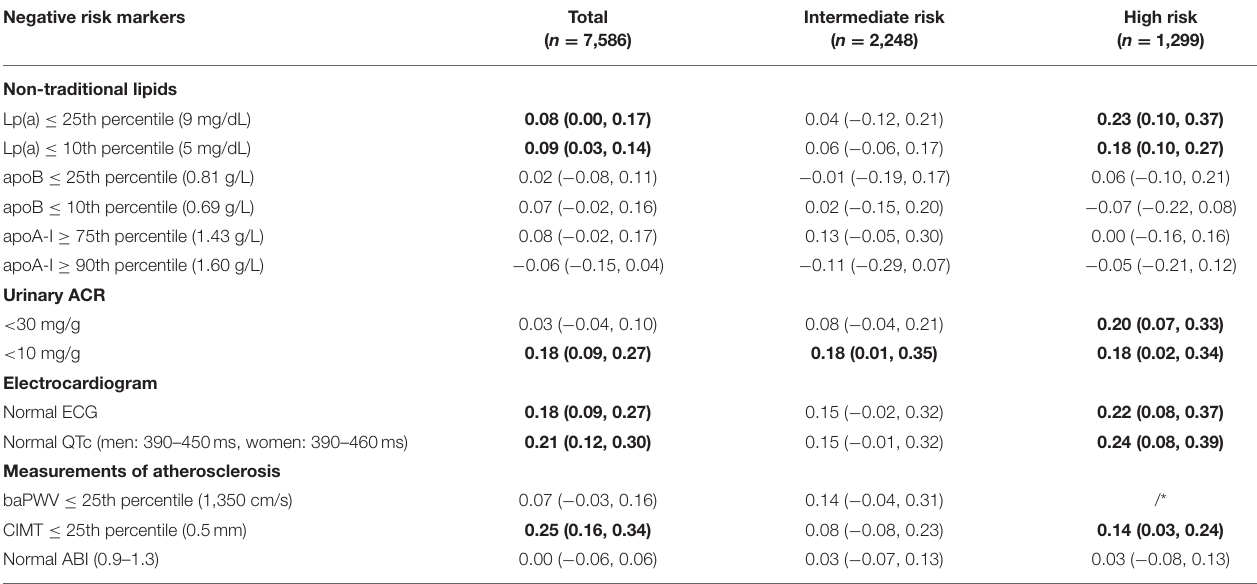
TABLE 4 | Continuous NRI for CVD risk by adding each negative risk markers to a basic model with traditional CVD risk factors. Negative risk markers